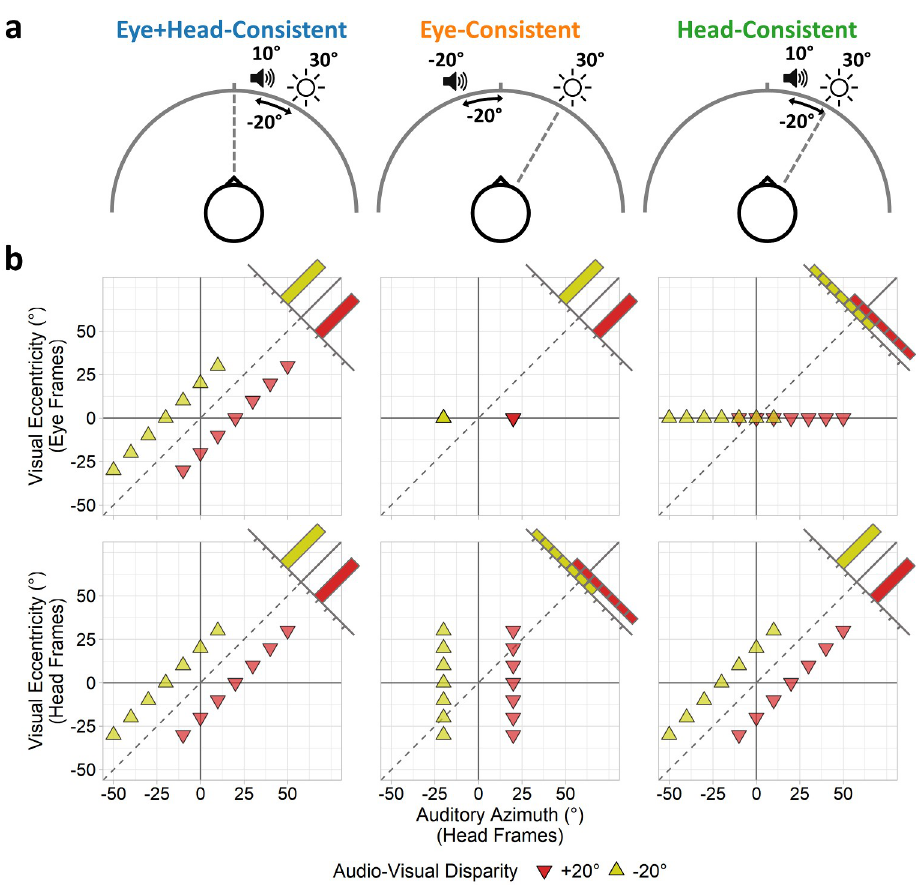
Fig 1. Experiment 1: Illustration of conditions. In the eye+head-consistent condition (left column), participants maintain central fixation and auditory stimuli are positioned relative to the visual stimulus location: consistent audio- visual spatial disparities are obtained from both eye- and head-centred visual frames. In the eye-consistent condition (middle column), participants maintain fixation at the visual stimulus location, and auditory stimuli are located relative to 0˚ azimuth: audio-visual spatial disparities remain consistent using eye-centred visual frames, but appear inconsistent using head-centred visual frames. In the head-consistent condition (right column), participants fixate the visual stimulus, and auditory stimuli are positioned relative to the visual stimulus: audio-visual spatial disparities remain consistent using head-centred visual frames, but appear inconsistent using eye-centred visual frames. (a) Stimuli and fixation positions for an example trial pairing a visual stimulus at +30˚ eccentricity with an auditory stimulus offset -20˚ leftward. (b) Stimulus locations: head-centred auditory azimuth plotted against visual eccentricity represented in eye-centred (top-row) and head-centred frames (bottom-row). Spatially consistent stimuli should lie parallel to the dotted line. Corner histograms illustrate distributions of audio-visual